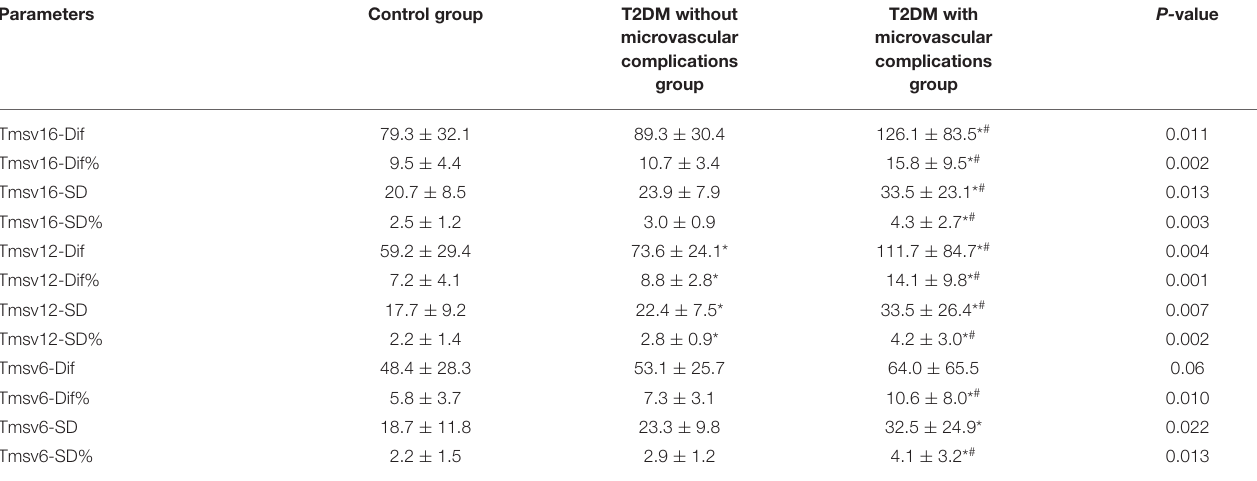
TABLE 2 | Comparison of parameters of 3DE in three groups.